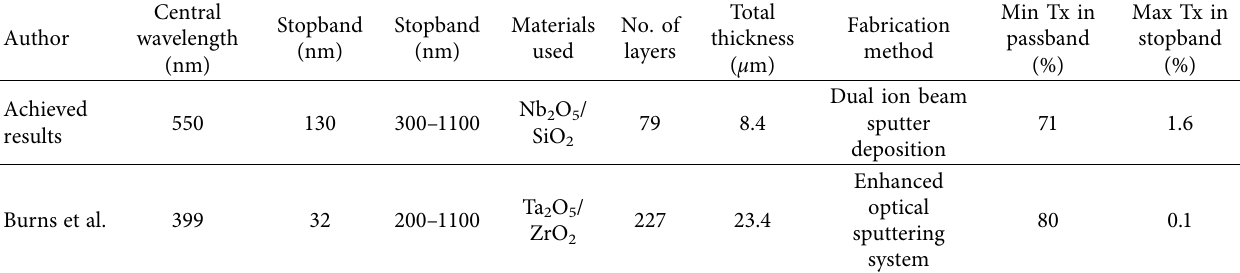
Table 2: Starting parameters of the Cauchy equation for SiO